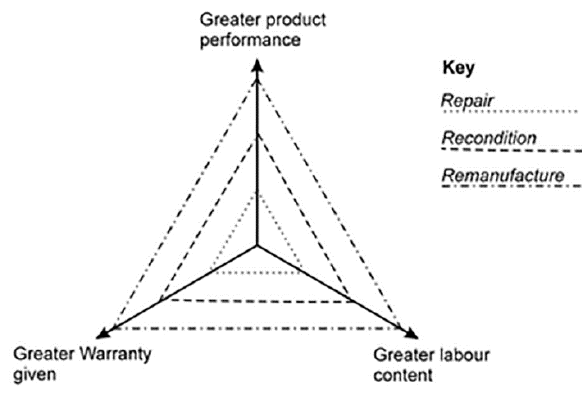
Figure 3. The hierarchy of secondary market production processes. Source: [39,40] .